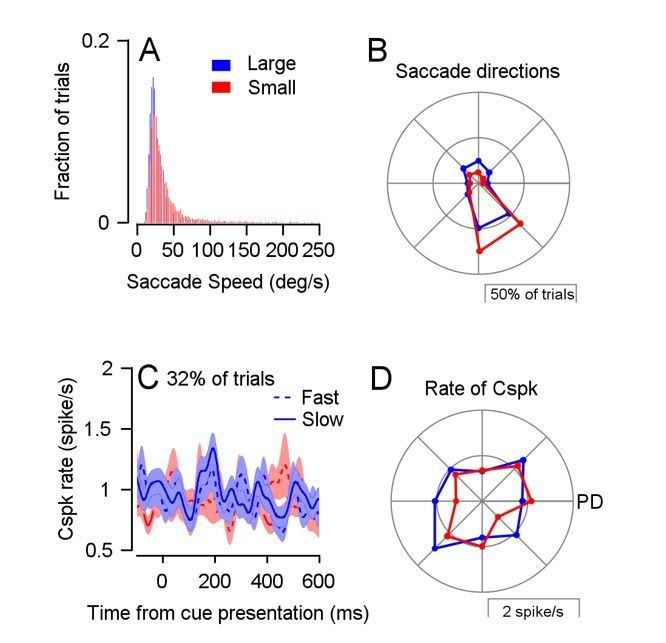
Analysis of saccade velocity and direction during the cue.(A) The distribution of saccade velocity in the 700 ms following the cue and proceeding target motion in both reward conditions. (B) The distribution of saccade directions in the same time period as A. (C) PSTHs aligned to cue for trials with slow and fast saccades (below the 40th and above the 60th percentile respectively). (D) The Cspk response following the cue in trials with different saccade directions. The right direction represents the PD of simple spikes for the same cell.